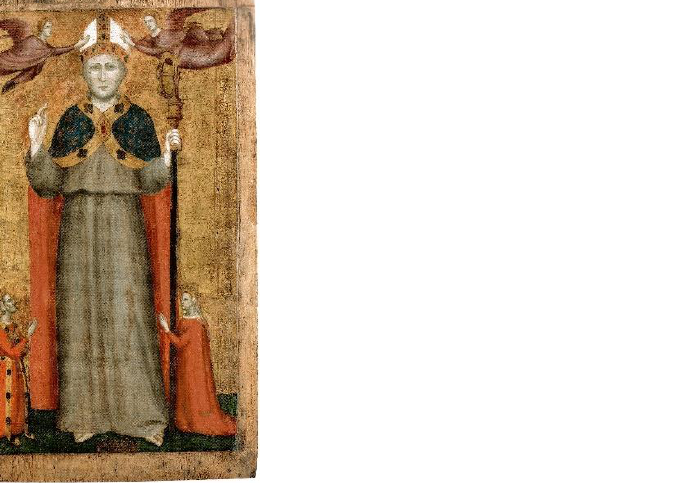
Figure 3. Master of Giovanni Barrile, Saint Louis of Toulouse worshipped by Robert of Anjou and Sancia of Majorca , painting on wooden panel, 1330–1336. Aix-en-Provence, Musée Granet. Image published in [12] (Figure 11).